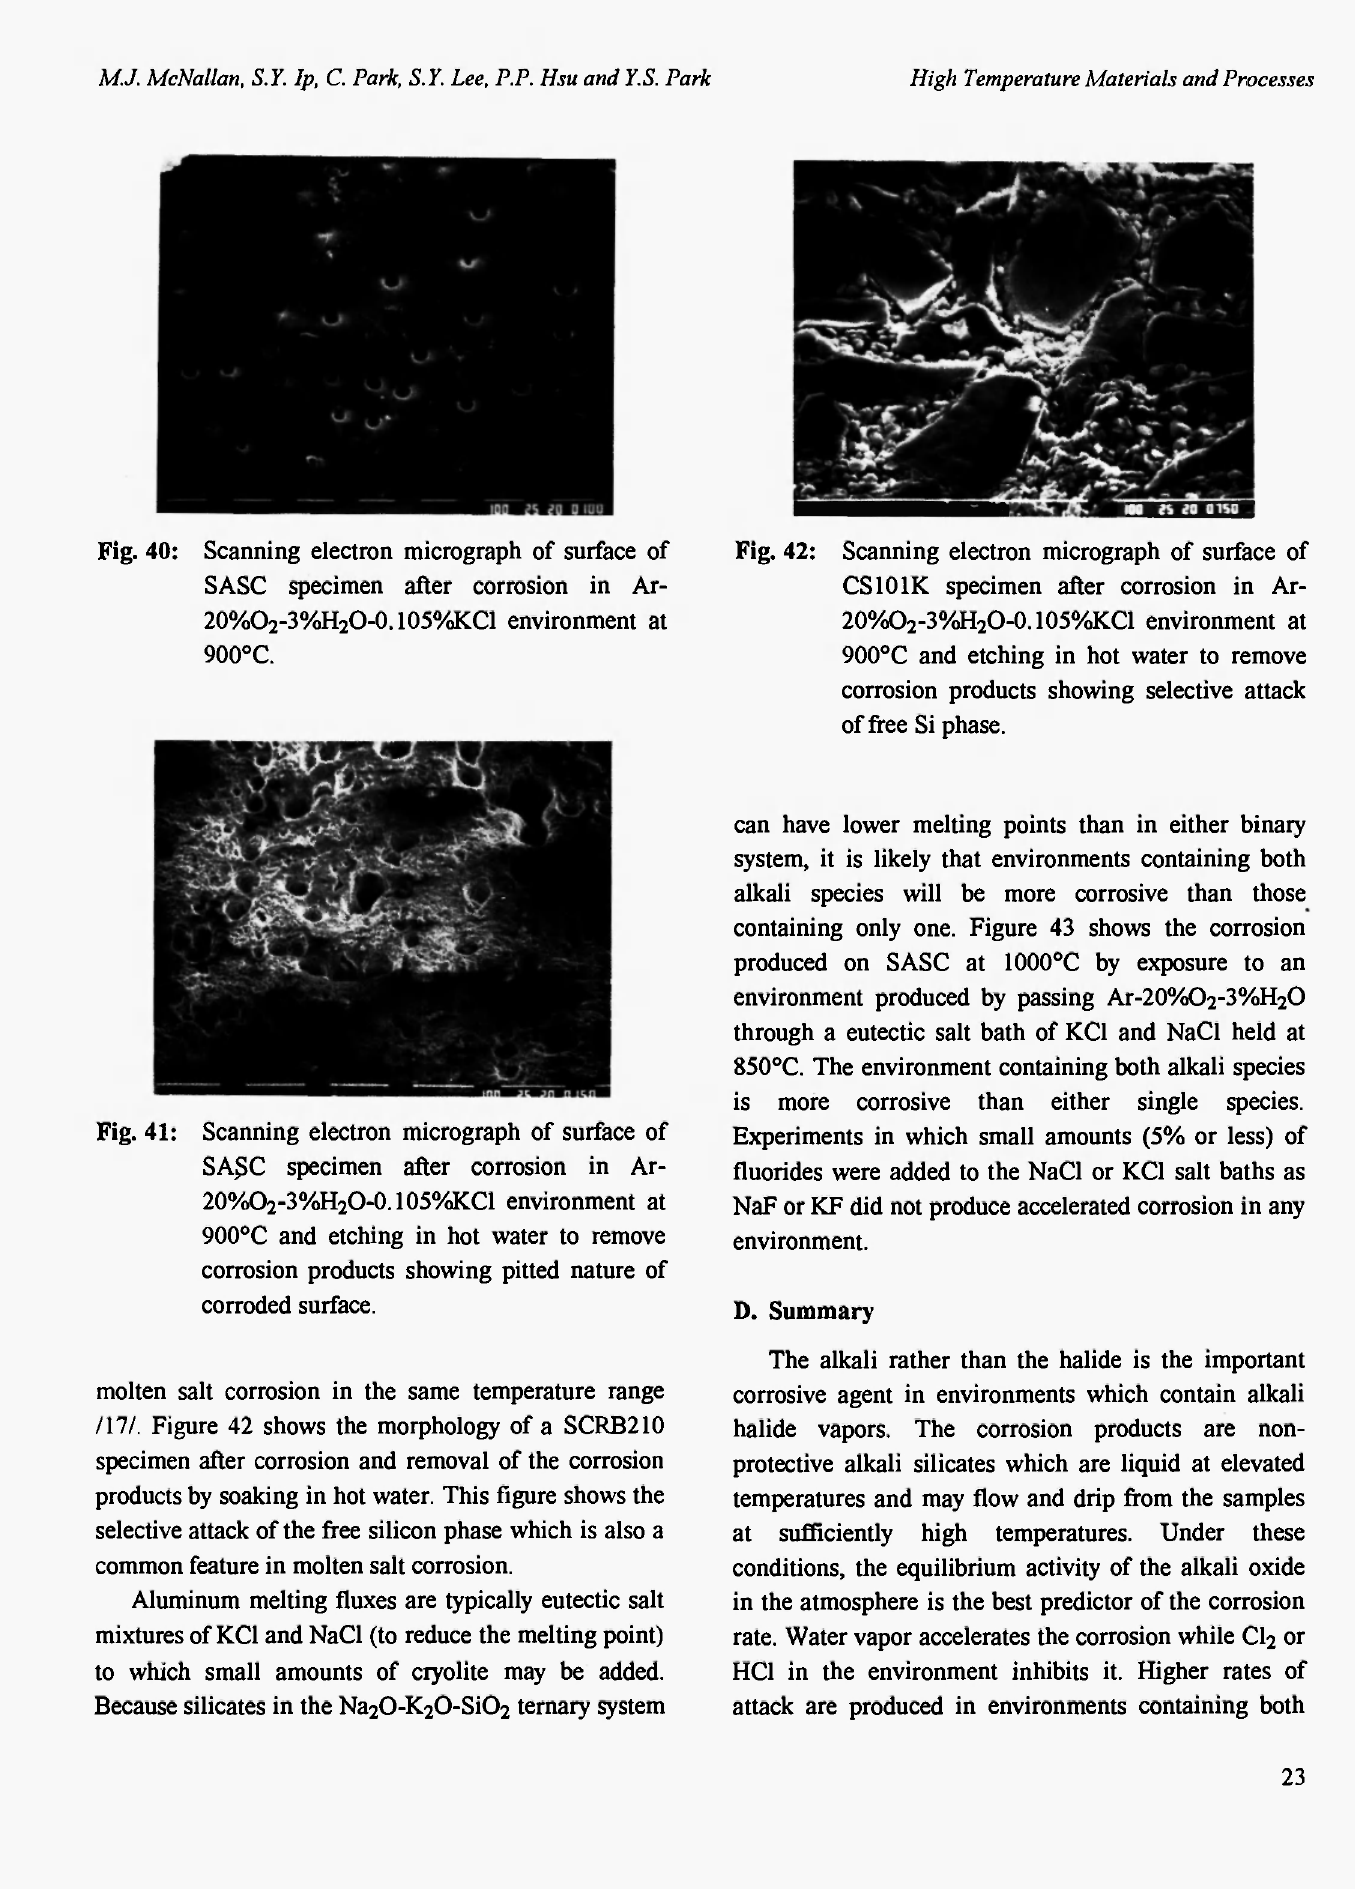
Fig. 40: Scanning electron micrograph of surface of SASC specimen after corrosion in Ar- 20%0 -3%H 0-0.105%KC1 environment at 2 2 900°C.